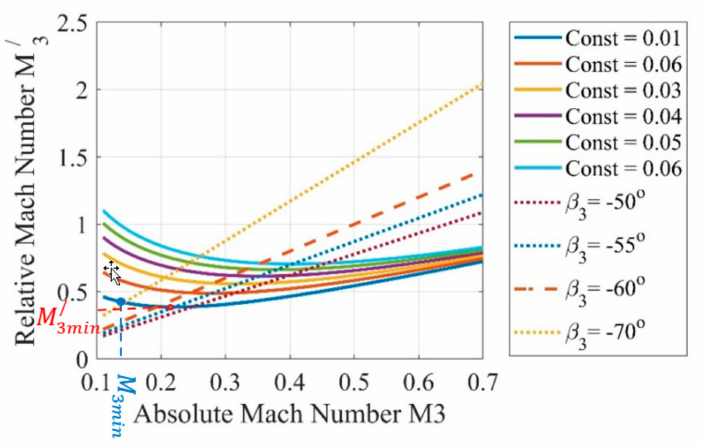
Figure 4. Variation in the value of Relative Mach number with absolute Mach number at various values of the exit blade